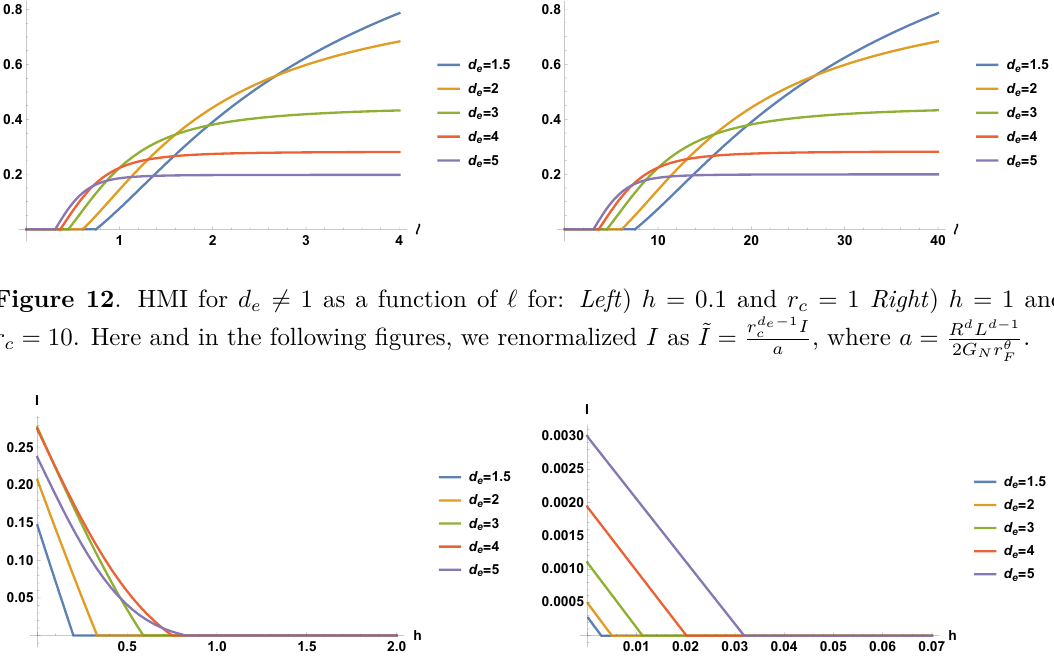
, h decreases by increasing r . e crit . c